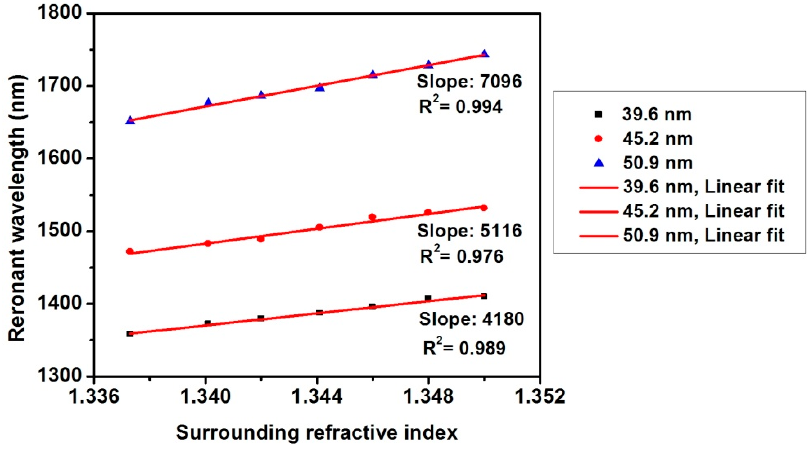
Figure 8. Relative resonant wavelength increases with increasing SRI for different TiO 2 film thickness.